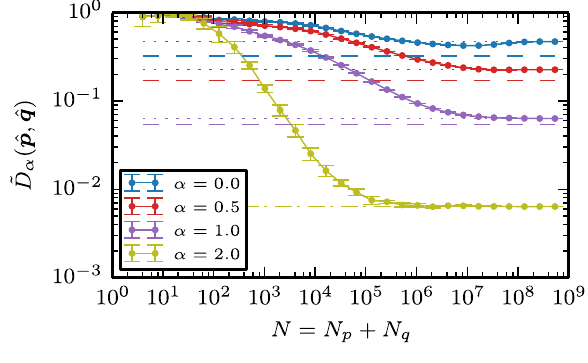
FIG. 7. JSD- α for sequences of different lengths.